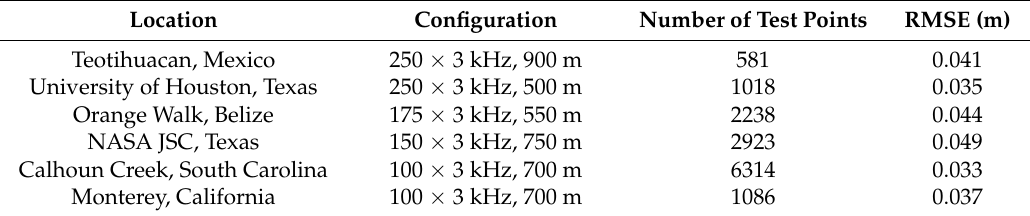
Table 11. Results from height accuracy assessments performed as part of mapping projects with different sensor PRFs and flying